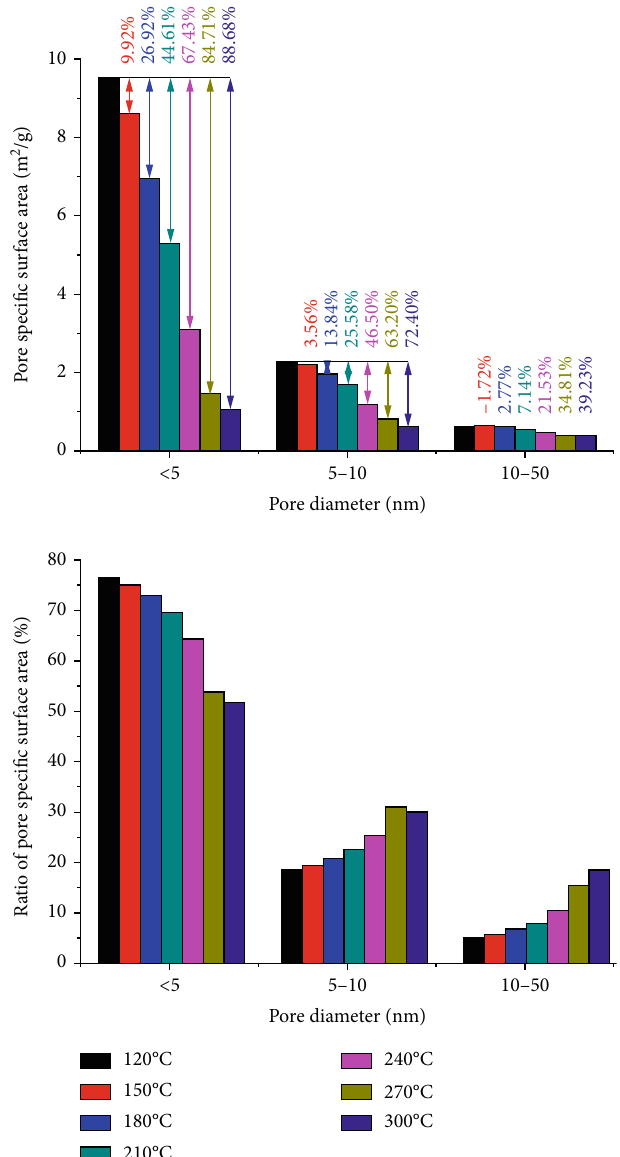
Figure 14: The dynamic change of the SSA and ratio of the mesopore with di ff erent pore ranges under various pretreatment